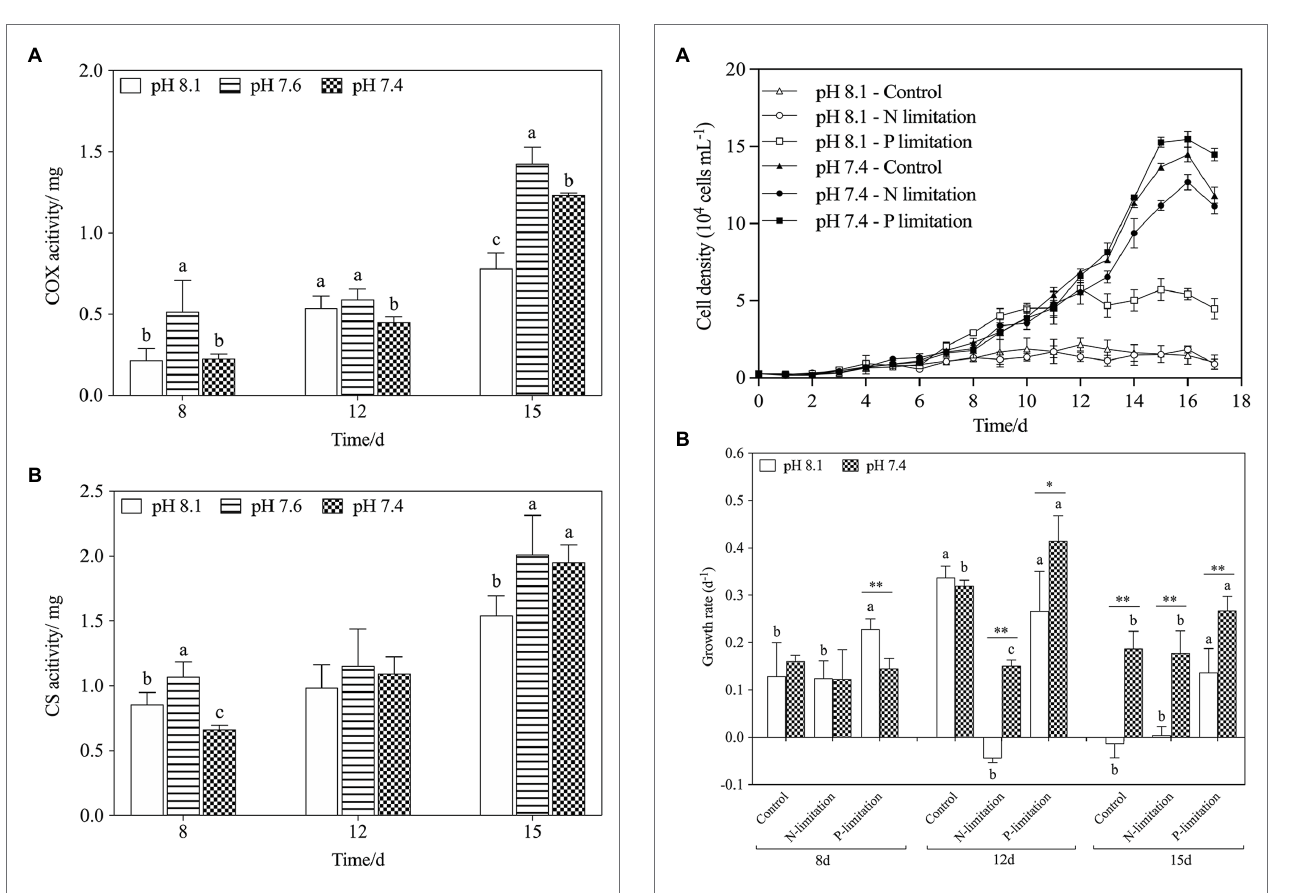
FIGURE 3 | Changes in mitochondrial metabolism-related enzyme activities in K. mikimotoi under exposure to different pH levels. (A) COX activity; (B) CS activity. Data are presented as means ± SD. Different lowercase letters indicate significant differences between the treatment and the control at each time point ( p <